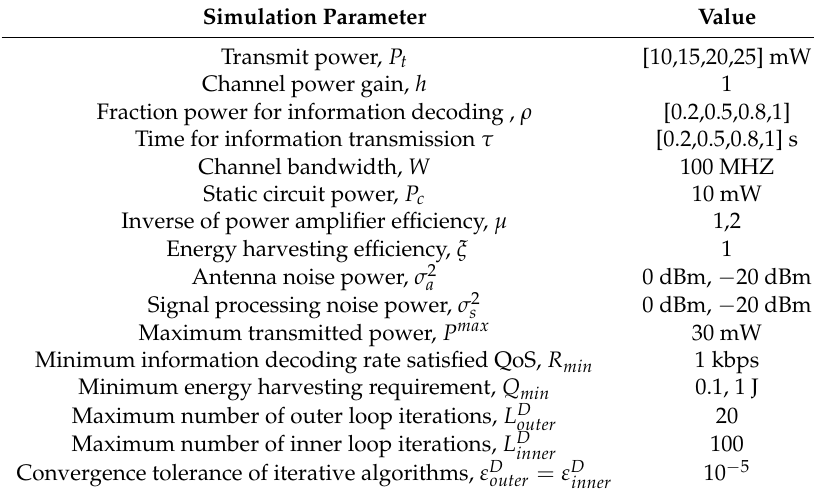
Table 2. Simulation parameters used in this section unless otherwise